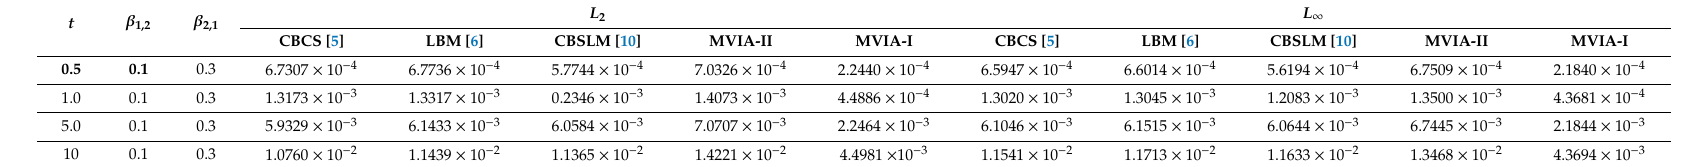
Table 1. Comparison of numerical results of u for di ff erent values of t and x for Test Problem 1.